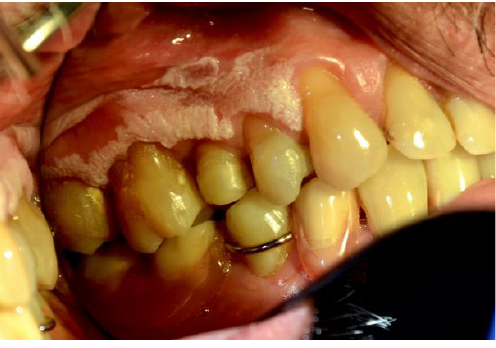
Figure 3. Hyperkeratosis.